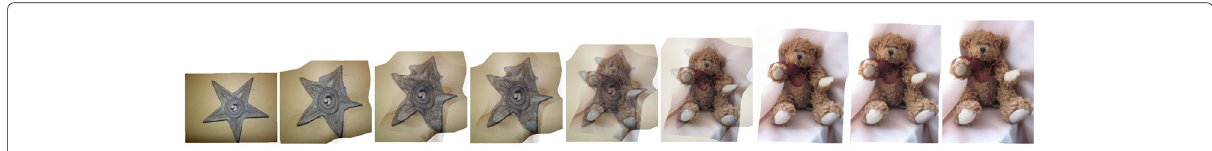
Fig. 9 Morphing result. Morphing from a star to a bear with a CAC